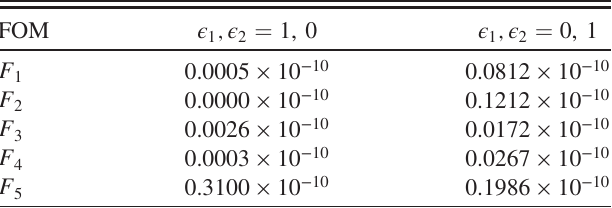
TABLE IV. Optimization results for minimizing components F F 4 and 5 from the FOM in Eq. (46).